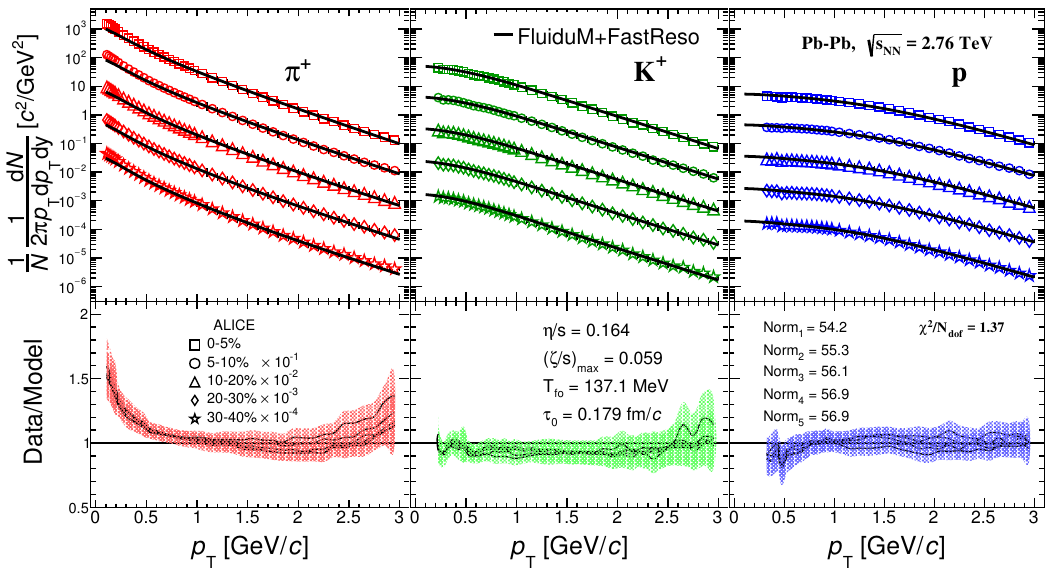
Figure 3 . Top: the best (cid:12)t for (cid:25); K; p spectra compared to the experimental data in (cid:12)ve centrality p classes in Pb-Pb collisions at s NN = 2.76 TeV. Bottom: the data to model ratios. The shaded areas correspond to the sum in quadrature of the statistical and systematic experimental